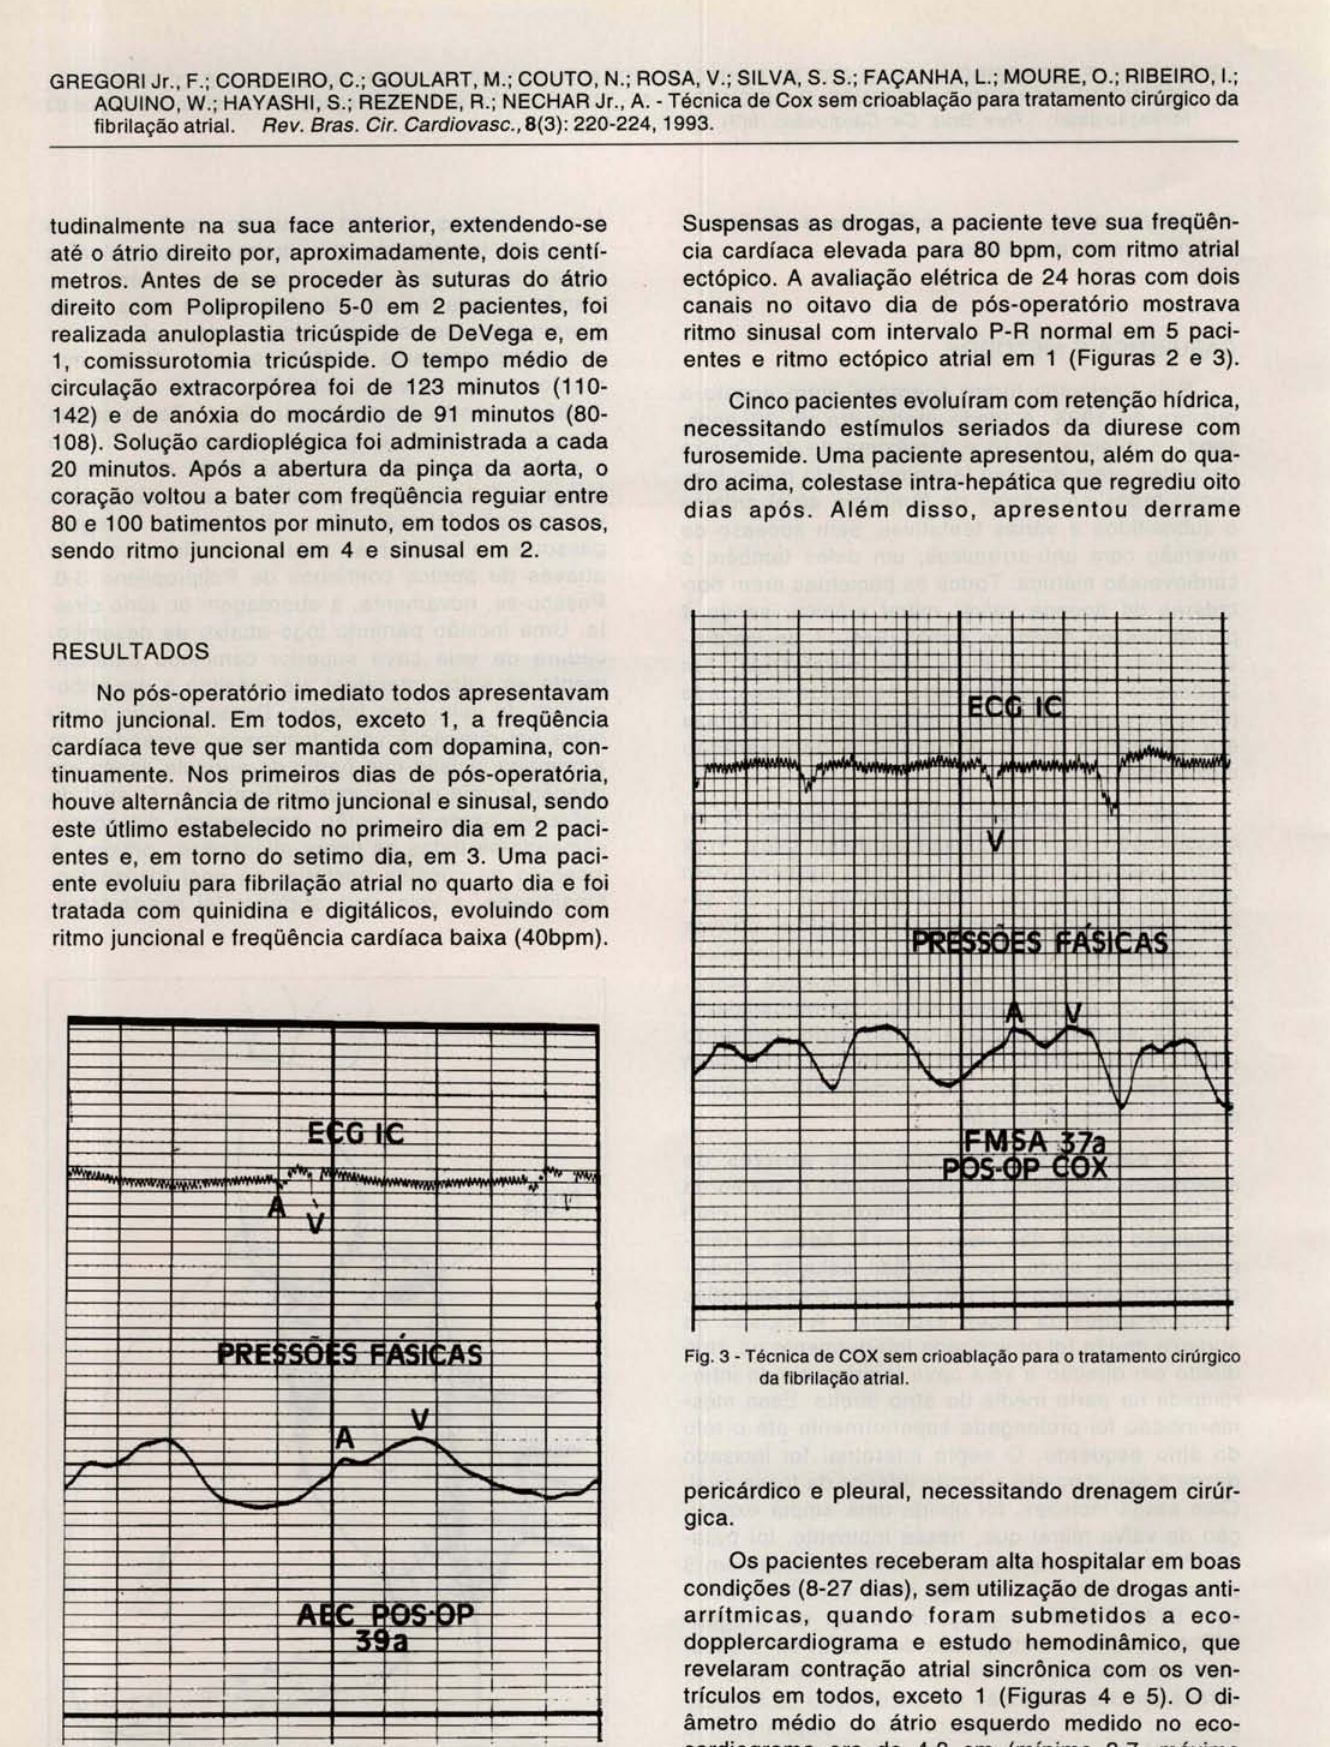
Fig. 2 . Técnica de COX sem crioablação para o tratamento cirúrgico da fibrilação atrial.